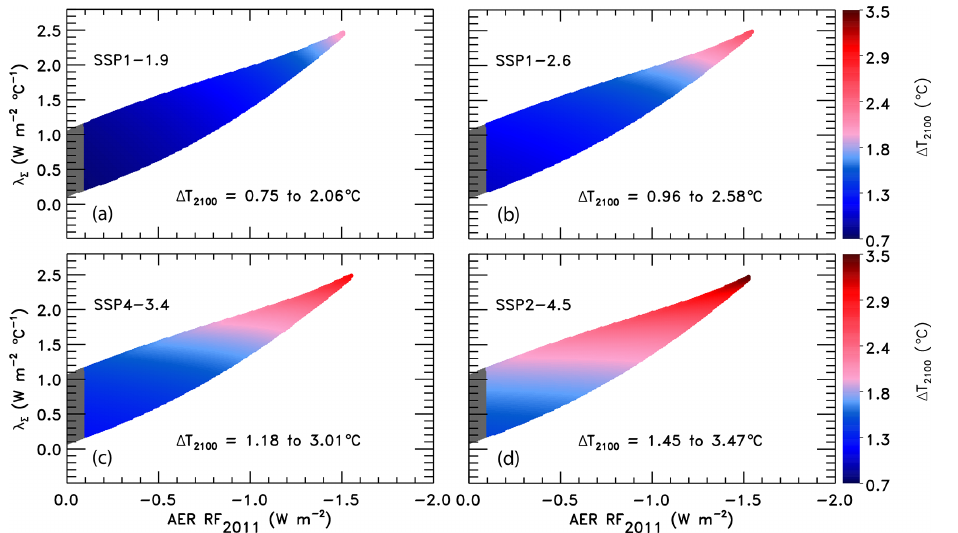
Figure 10. (cid:49)T 2100 as a function of climate feedback parameter and tropospheric aerosol radiative forcing in 2011 using the EM-GC trained with the HadCRUT5 (cid:49)T record. (a) Future GMST change for SSP1-1.9. The region outside the AER RF 2011 range provided by IPCC 2013 is shaded (grey). Colors denote the GMST change in the year 2100 relative to pre-industrial. The color bar is the same across all four panels for comparison. (b) GMST anomaly for SSP1-2.6. (c) Future temperature change for SSP4-3.4. (d) GMST anomaly for SSP2-4.5.